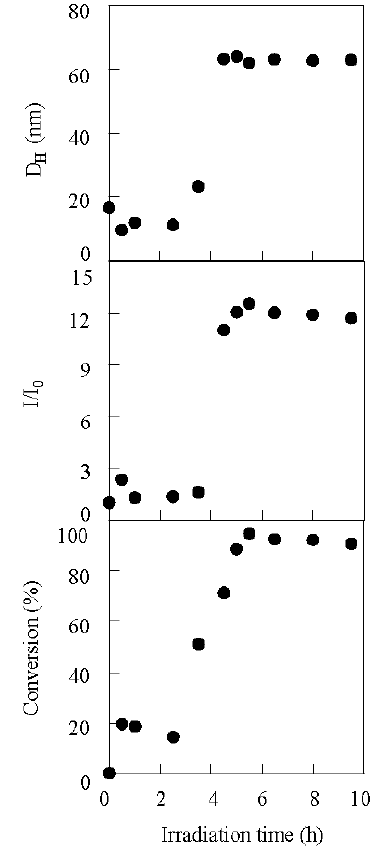
Figure 1. The variation in the hydrodynamic diameter (D (I/I ), and the BAI. 0